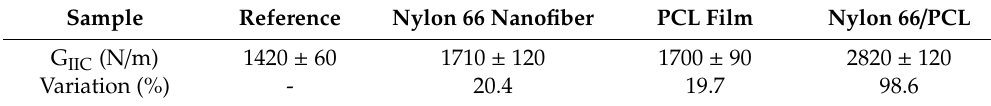
Table 5. The influence of PCL film, Nylon 66 nanofibrous mat, and their mixture on G IIC [39].